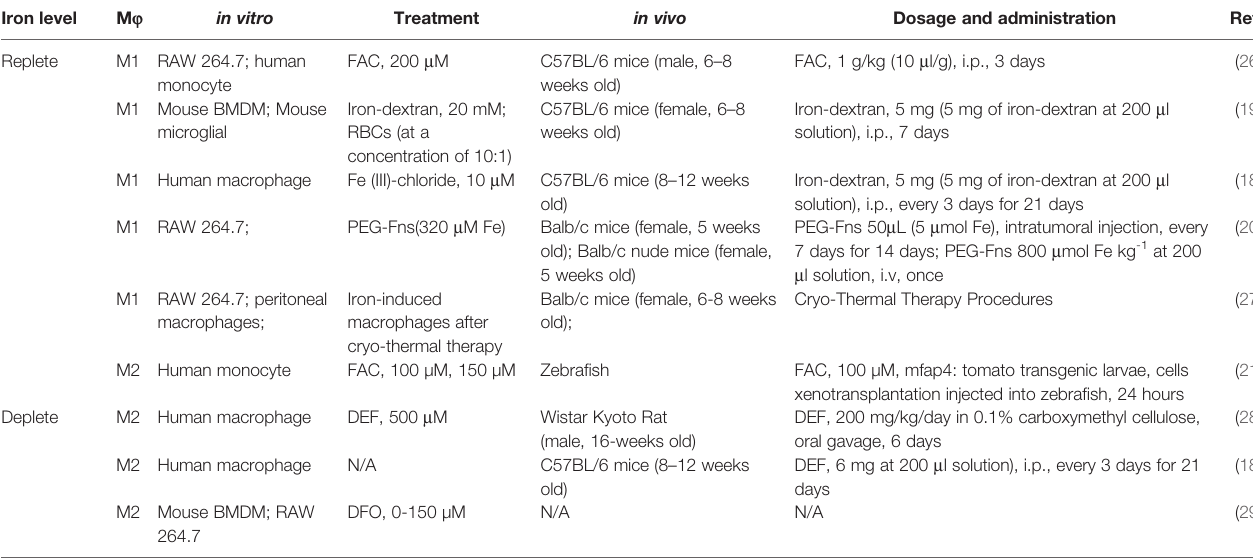
TABLE 1 | Iron and macrophage